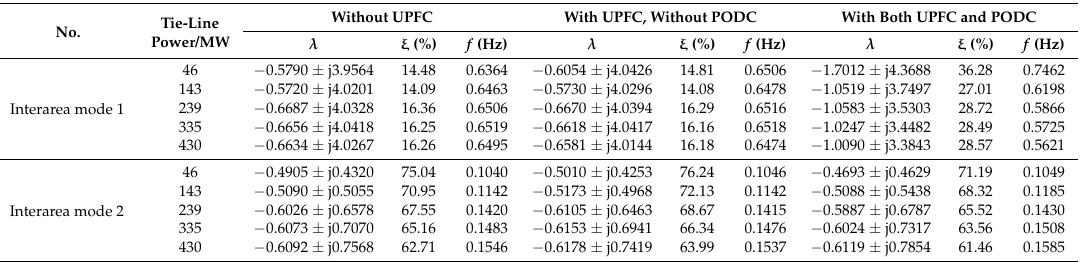
Table 4. The interarea oscillation modes under different degrees of the tie-line power flow. No.